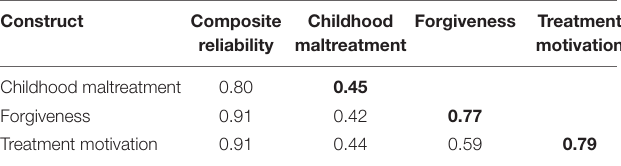
TABLE 1 | Discriminant validity index summary.